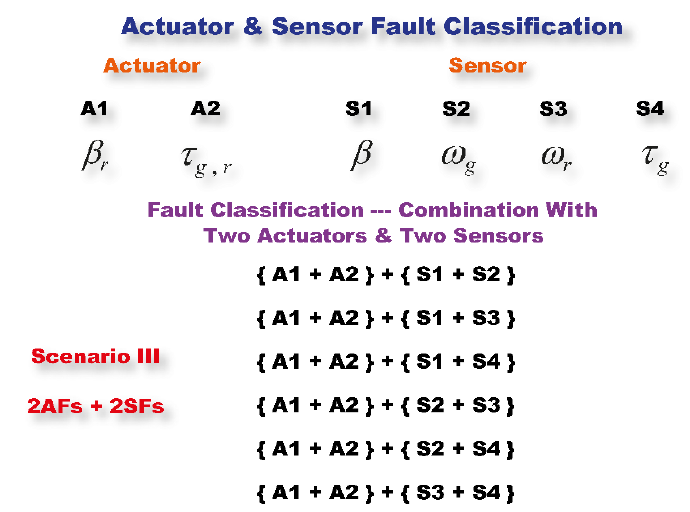
Figure 7. Experimentation design for actuator and sensor fault classification, under Scenario III (2AFs + 2SFs).